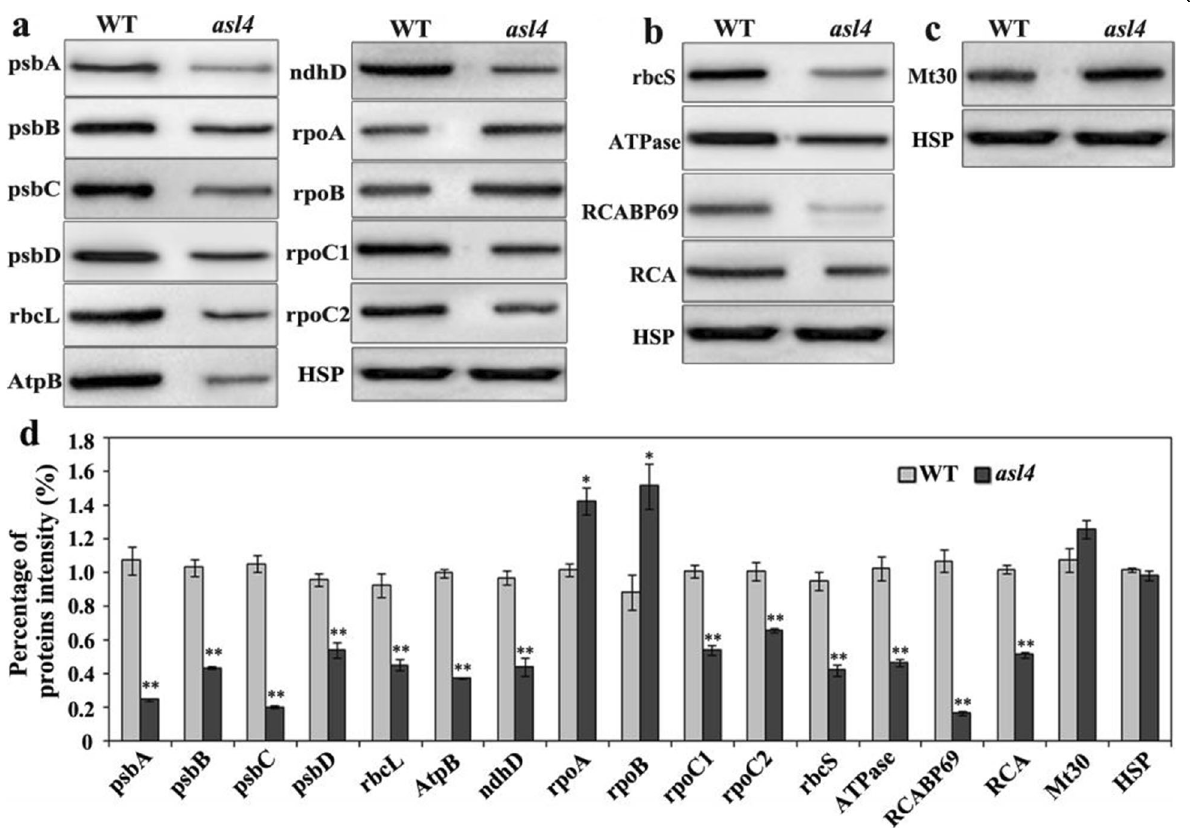
Fig. 8 Levels of selected representative proteins. a Western blot analysis of plastid-encoded proteins in wild-type and asl4 mutant seedlings at the L3 stage. b Western blot analysis of nuclear-encoded proteins in wild-type and asl4 mutant seedlings at the L3 stage. c Western blot analysis of mitochondrial-encoded proteins in wild-type and asl4 seedlings at the L3 stage. HSP 82 was used as internal control. d Quantification of the band intensity of the detected proteins in asl4 mutant compare to wild type corresponding to a - c . Data are means ± SD of three independent repeats. ** and *, indicate significance at P = 0.01 and P = 0.05, respectively, by Student ’ s t